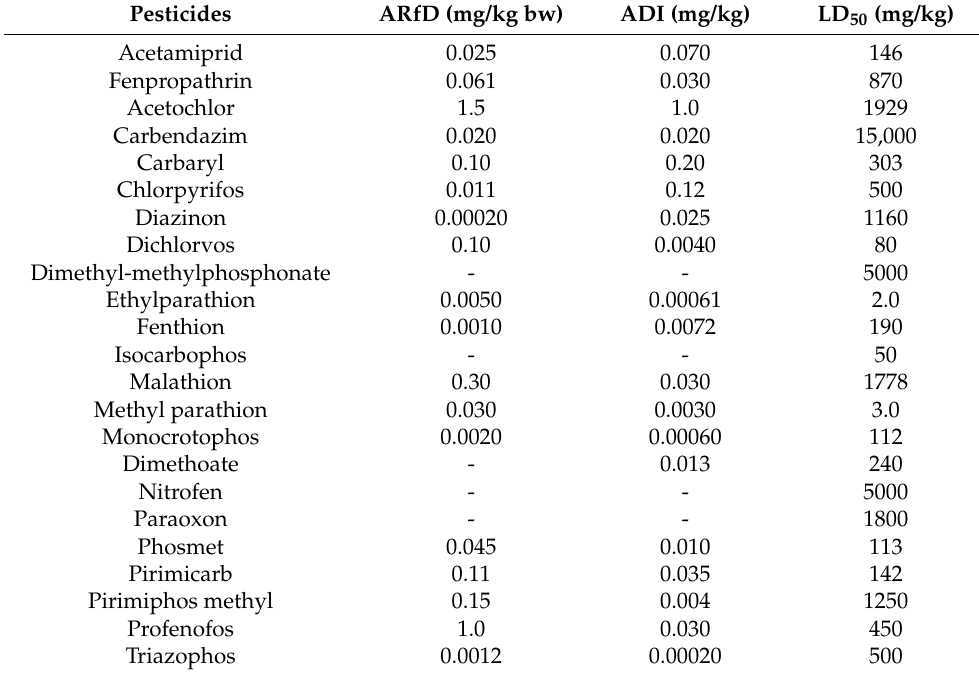
Table 4. Toxicological data established by USEPA regarding pesticides detected by biosensors. Pesticides ARfD (mg/kg bw) ADI (mg/kg) LD 50 (mg/kg)